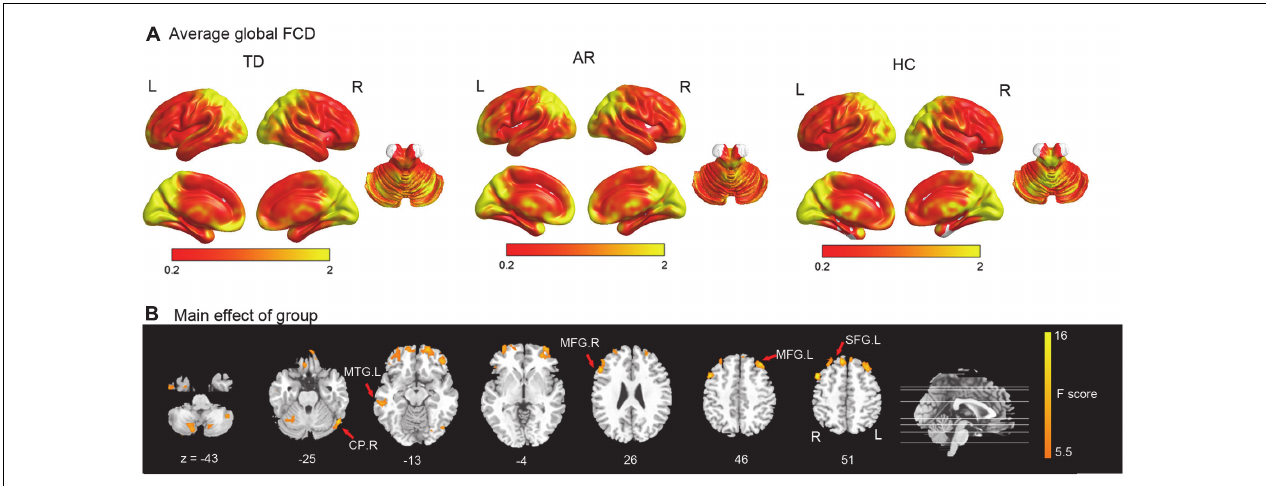
FIGURE 1 | Results of the FCD analyses. (A) Shows the spatial distribution of the average global functional connectivity density (FCD) for TD, AR, and HC. (B) Show result of the significant main effect of group on FCD (one-way ANCOVA, p < 0.005 corrected for multiple comparison at the cluster level, AlphSim corrected). CP, cerebellum posterior lobe; MTG, middle temporal gyrus; MFG, middle frontal gyrus; SFG, superior frontal